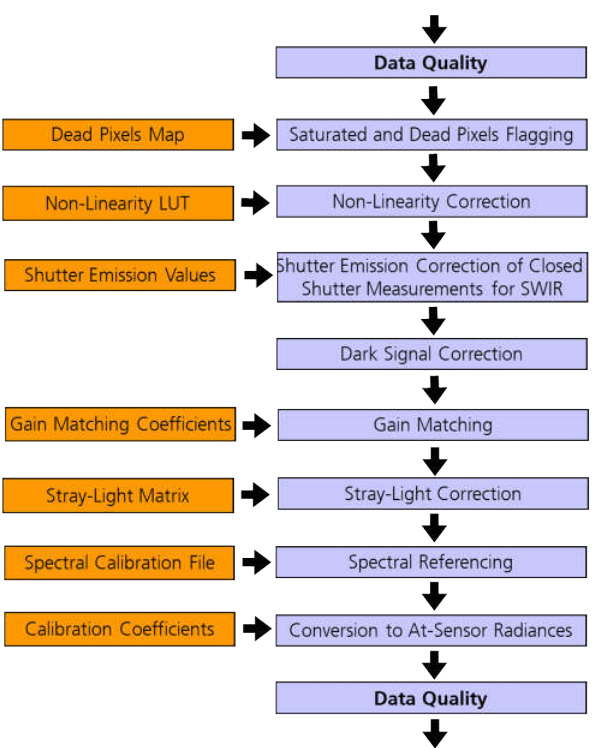
Figure 6. Radiometric correction